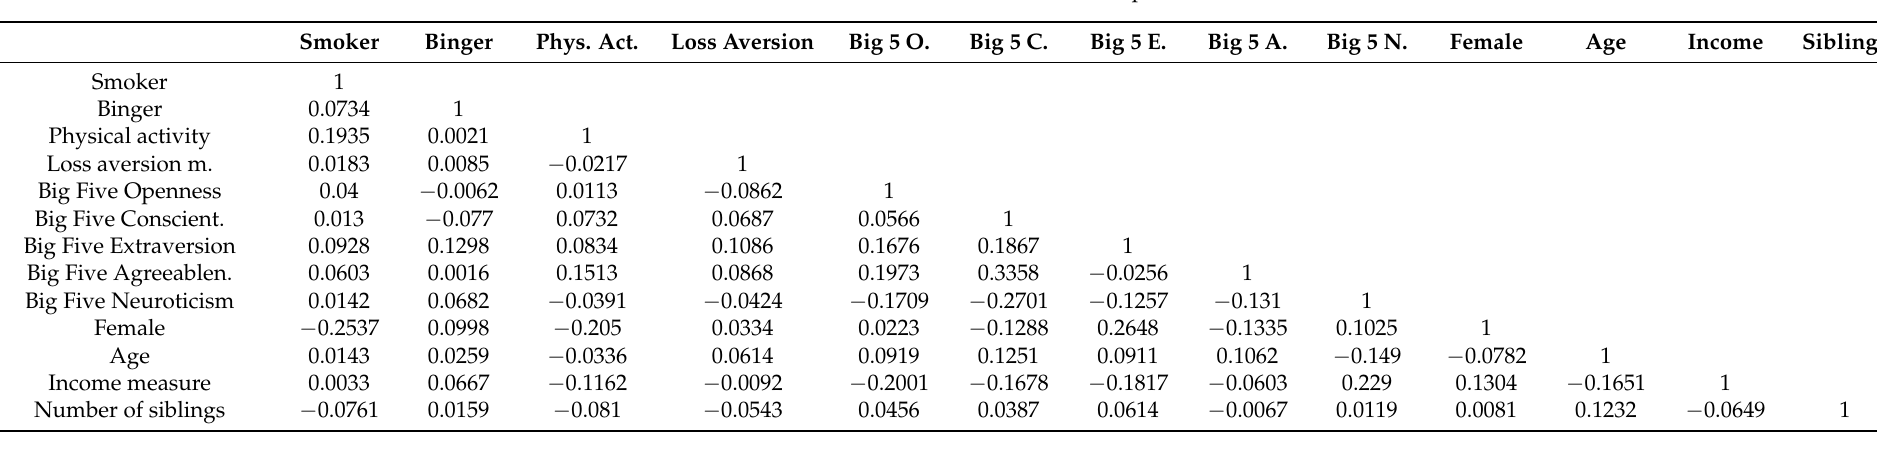
Table A2. Correlation matrix, US